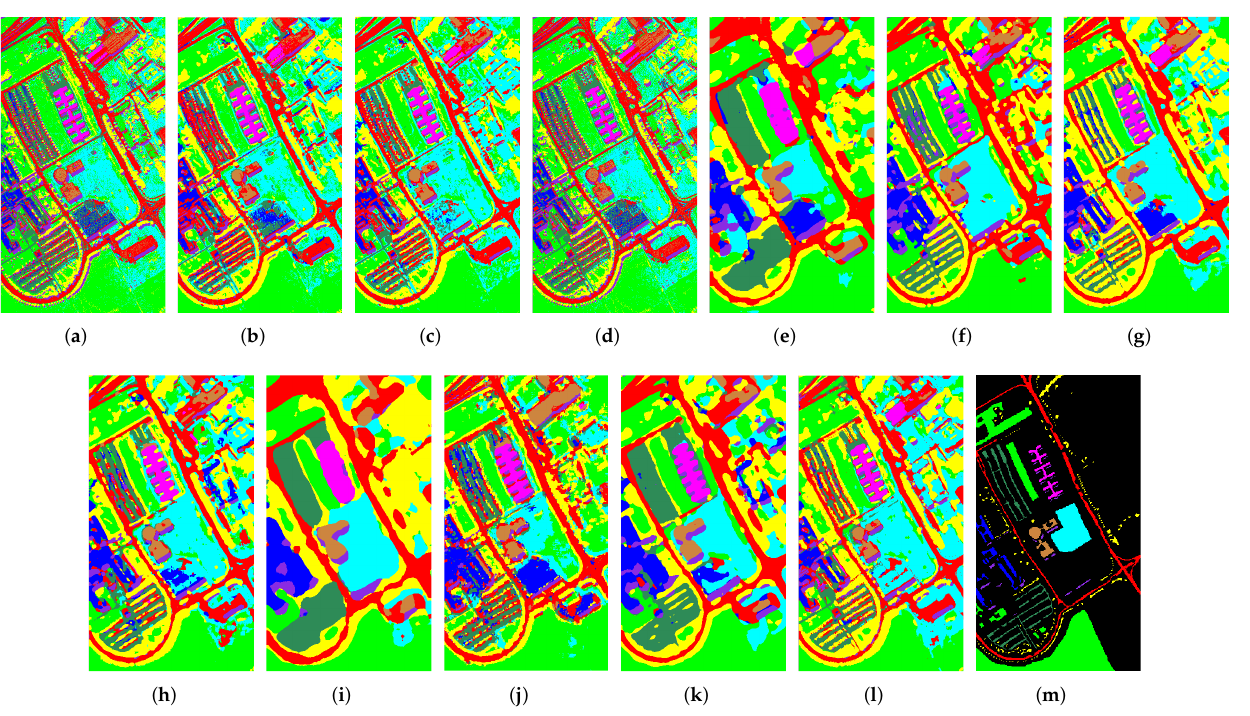
Figure 9. Classification maps for the UP data set obtained by ( a ) SVM, ( b ) CDCNN, ( c ) 3DCNN, ( d ) SSRN, ( e ) DFFN, ( f ) MFDN, ( g ) CBW, ( h ) FGSSCA, ( i ) LDN, ( j ) S2FEF, ( k ) S3EResBoF, ( l ) LMFN, and ( m ) Ground